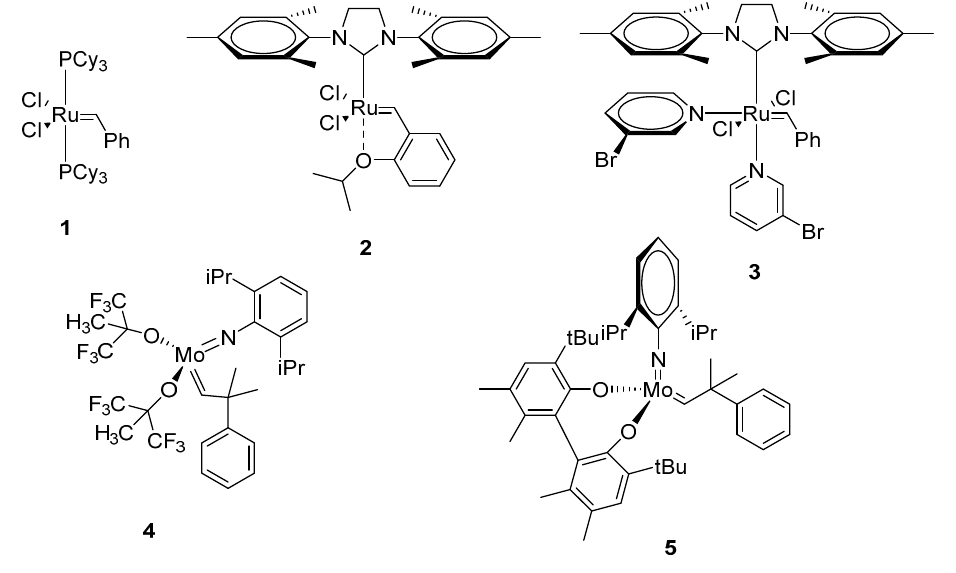
Figure 1. Examples of olefin metathesis catalysts 1 – 5 .